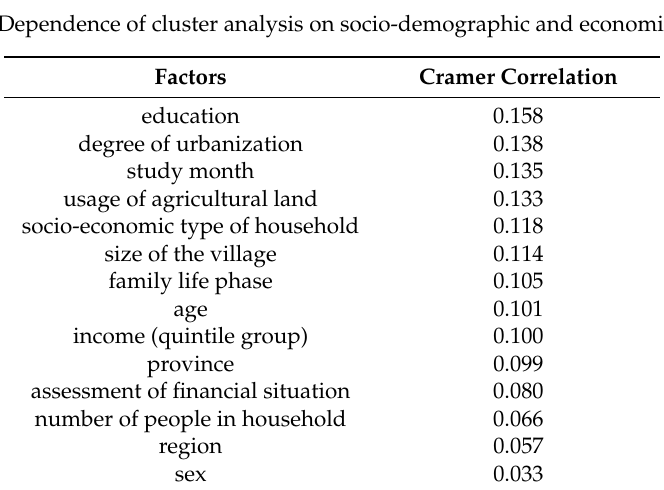
Table 9. Dependence of cluster analysis on socio-demographic and economic factors.